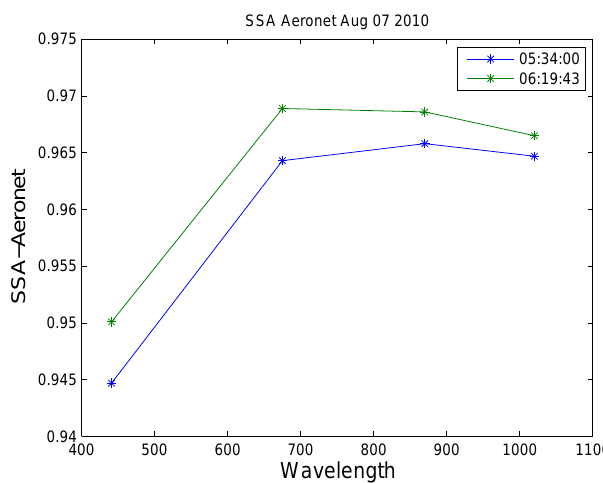
Figure 6. SSA wavelength dependence of the AERONET inver- sion product for 7 August 2010 at the Moscow-MSU-MO station. The average AOD reported by AERONET was 3.67, the fine-mode fraction (FMF) was 0.98 the volume median radii were 3.24 and 3.43µm respectively and the Ångström Exponent was